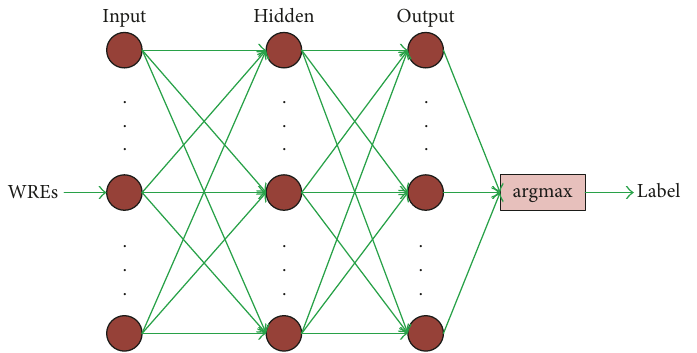
Figure 4: Diagram of an FNN.